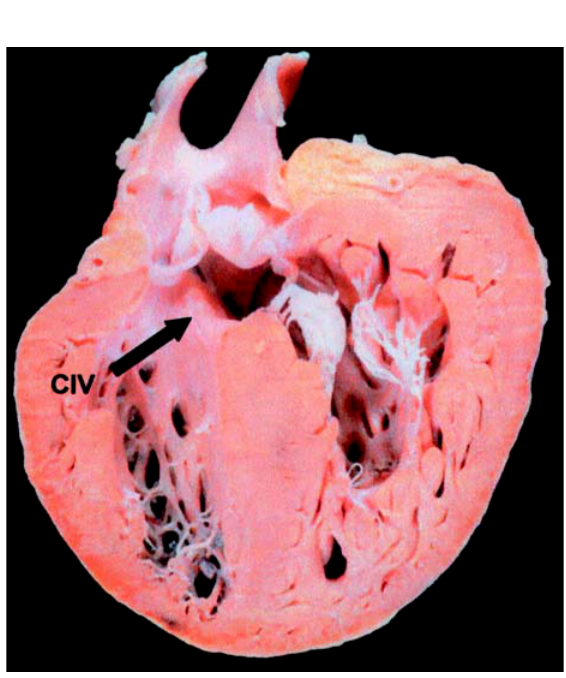
Fig. 2 – Espécime anatômico demonstrando comunicação interventricular (CIV) perimembranosa.